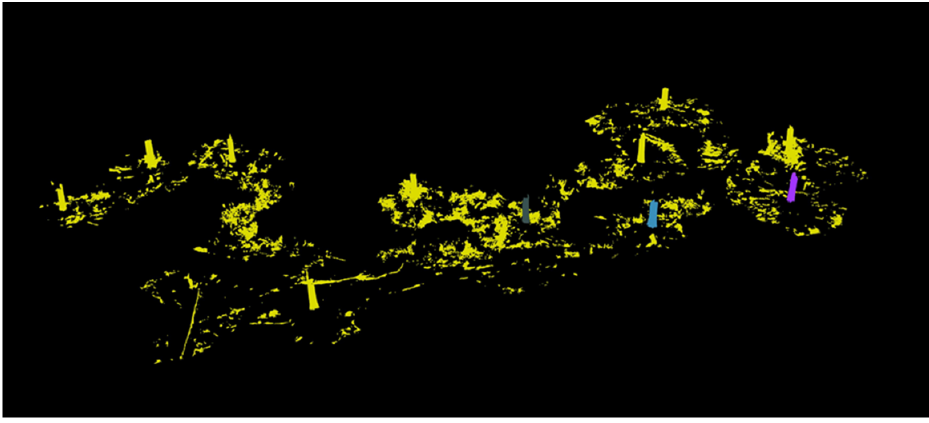
Figure 13. Selecting trees in manual tree selection mode with 3D Forest software.